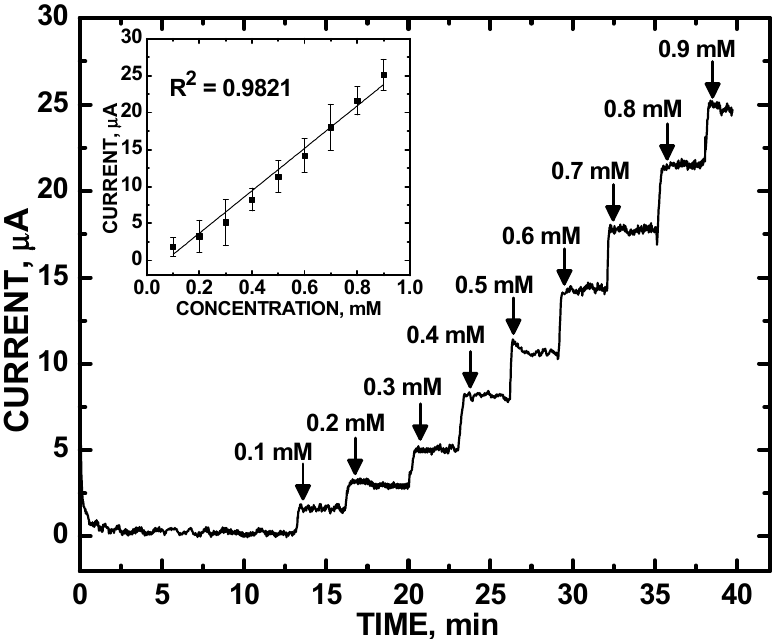
Figure 6. CA response of ZnO/COOH-MWNTs in phosphate buffer solutions (PBS), upon addition of UA from 100–900 μ M; inset shows calibration curve.